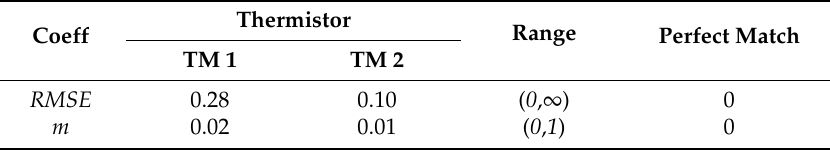
Table 4. Calculated efficiency coefficients for each thermistor.